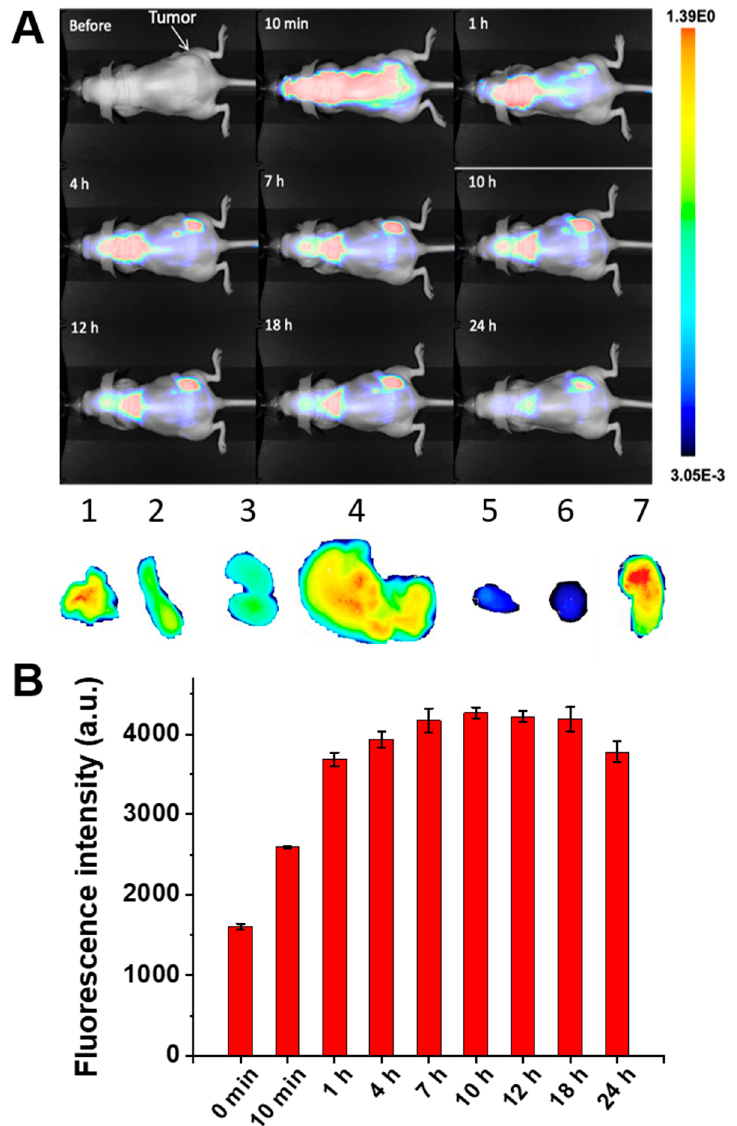
Figure 7. ( A ) NIR fluorescence images of a mouse with DU145 xenograft at different time points following intravenous administration of SiNc-loaded ZnMn-IONCs (top panel). Organs and tumor distribution of SiNc-loaded ZnMn-IONCs 18 h after intravenous injection (lower panel). 1—lungs; 2—spleen; 3—kidneys; 4—liver; 5—heart; 6—brain; 7—tumor. ( B ) The NIR fluorescence intensity was measured in the tumor as a function of time after intravenous injection of SiNc-ZnMn-IONCs in a mouse bearing a DU145 tumor.